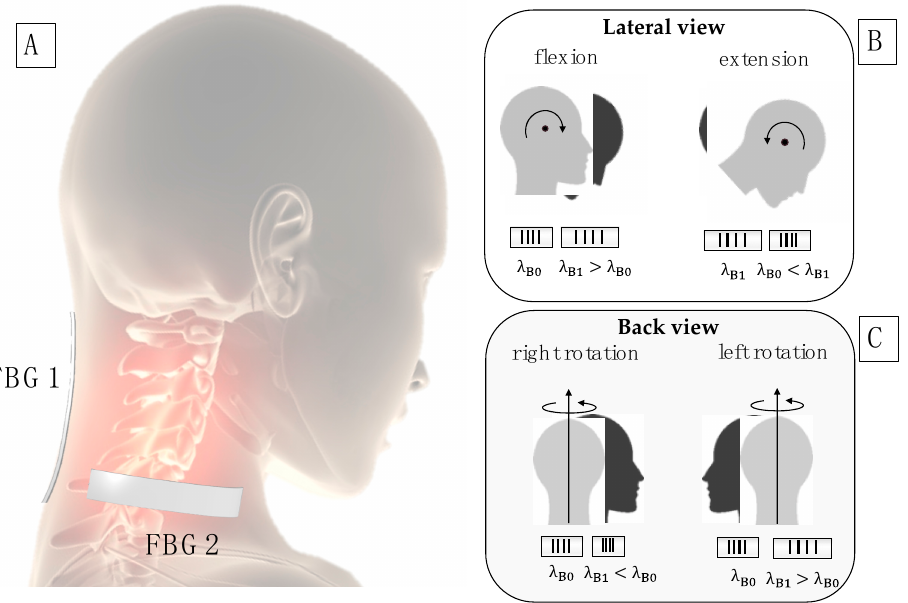
Figure 2. ( A ) Sensors’ positions; ( B ) schematic representation of the FBG1 response to flexion-extension (FE) movements; ( C ) schematic representation of the FBG2 response to axial rotation (AR) movements.